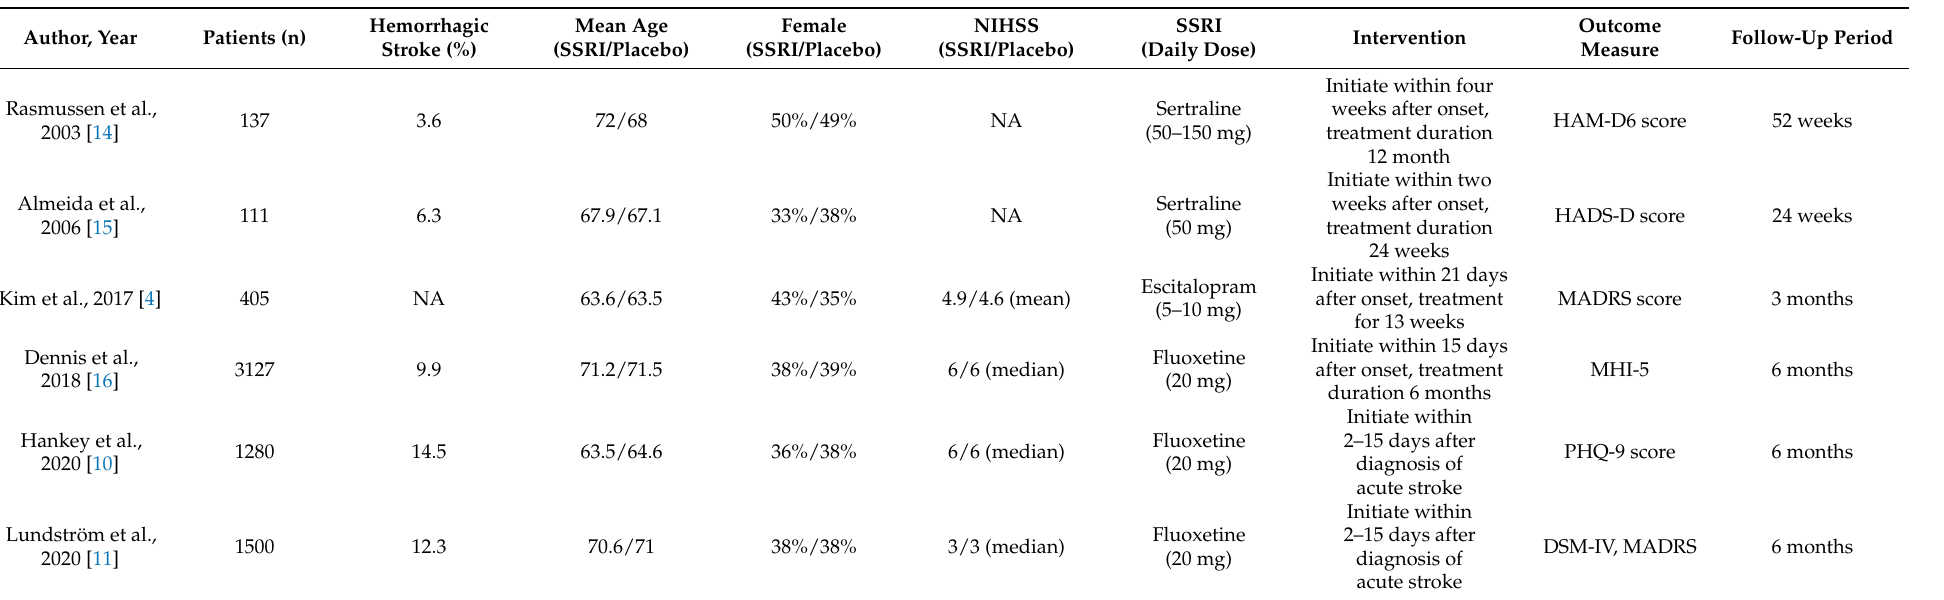
Abbreviations: NIHSS, National Institutes of Health Stroke